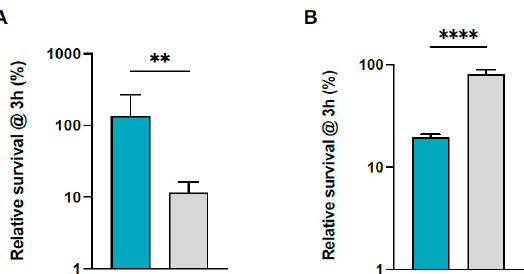
Figure 4. S. pettenkoferi SP165 and S. aureus SA564 survival in whole blood. Percentage survival of S. pettenkoferi SP165 (blue) and S. aureus SA564 (grey) in ( A ) freshly collected human whole blood and ( B ) human plasma. Bacteria were cultivated overnight, diluted, inoculated in blood or human plasma, maintained for 3 h at 37 ◦ C, and rotated. Percentage survival = (CFU timepoint /CFU initialinput ) ∗ 100. The data are the average with standard deviation of five separate experiments. ** p < 0.01; **** p < 0.0001 (Mann–Whitney U test).